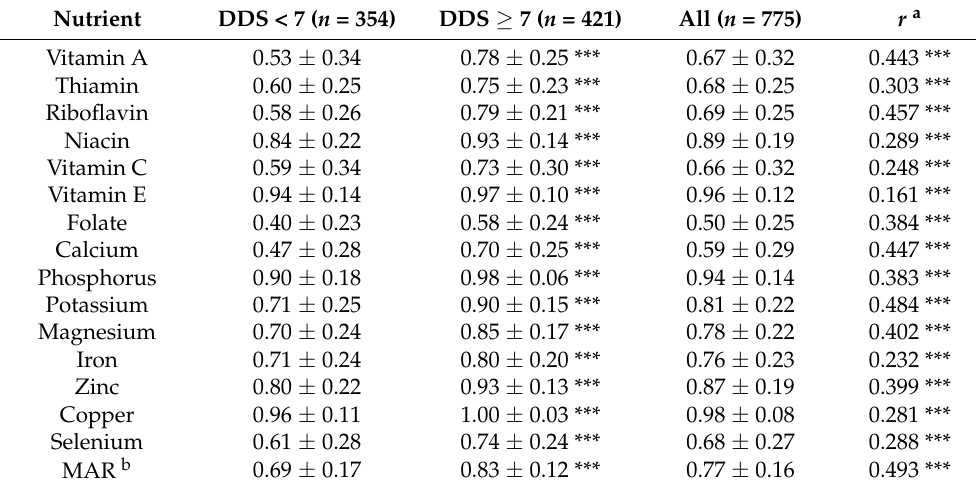
Table 3. Mean nutrient adequacy ratio (NAR) for nutrients according to the dietary diversity score